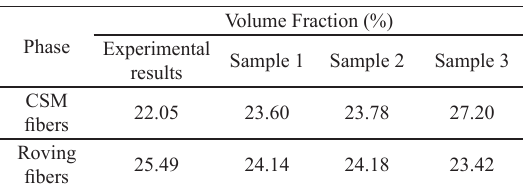
Table 5. Content of fibers for CSM and roving layer from each sample compared to the experimental results.